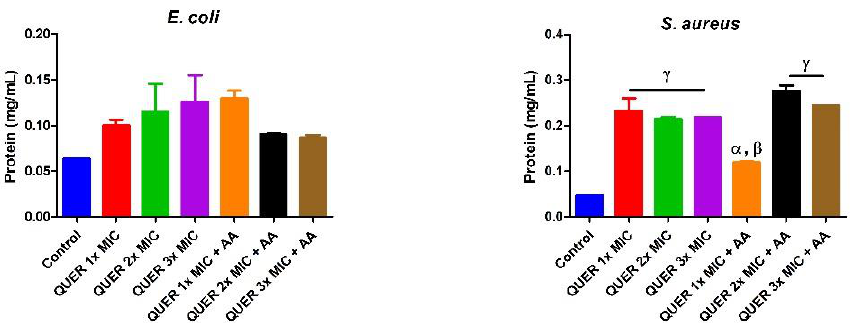
Figure 1. Protein concentration in bacterial isolates following treatment with quercetin (QUER) alone or combined with ascorbic acid (AA) . Results are presented as an average of duplicate biological experiments (n = 2) with the corresponding standard error of the mean (SEM). Compared with the control, α at p < 0.05 and γ at p < 0.0001 are significant, while β is significant at p < 0.01 relative to QUER 1x MIC.